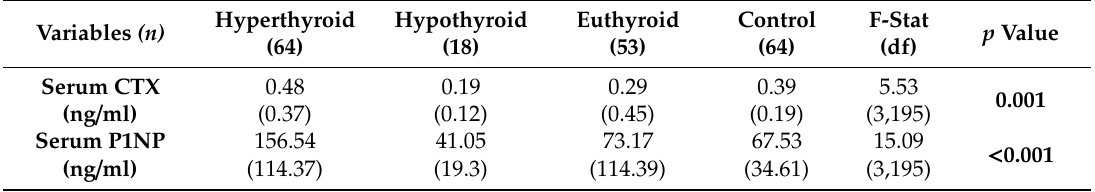
Table 8. ANOVA analysis. Comparison between mean serum CTX and serum P1NP in between groups.